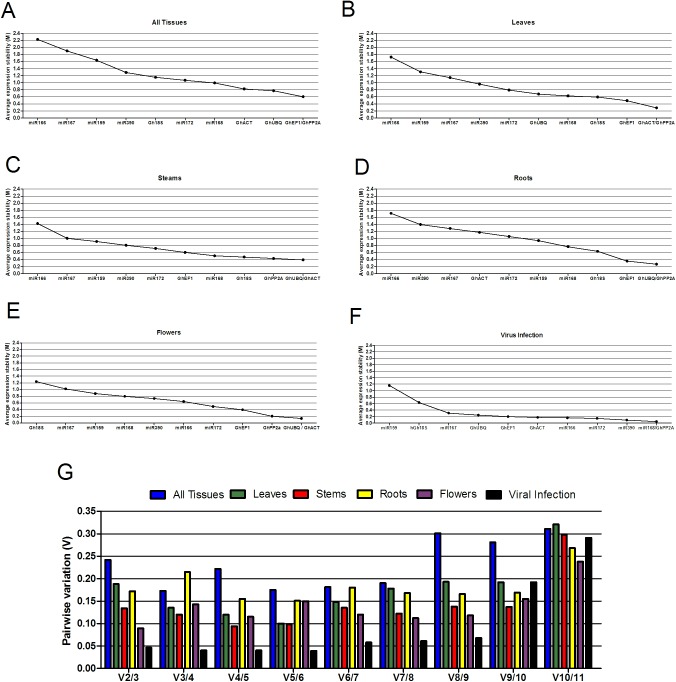
geNorm analysis of the average expression stability values and ranking of the eleven candidate reference genes based on pairwise comparisons.Gene expression stability (M value–y-axis) is shown for the candidate reference genes (x-axis) from the most to the least stable. A- All tissues (set 12); B- leaves (set 1); C—stems (set 2); D—roots (set 3); E- flowers (set 4); and F- virus infection (set 11). G- pairwise variation (V) of the all tissues (set 12), leaves (set 1), steams (set 2), roots (set 3), flowers (set 4) and virus infection (set 11).